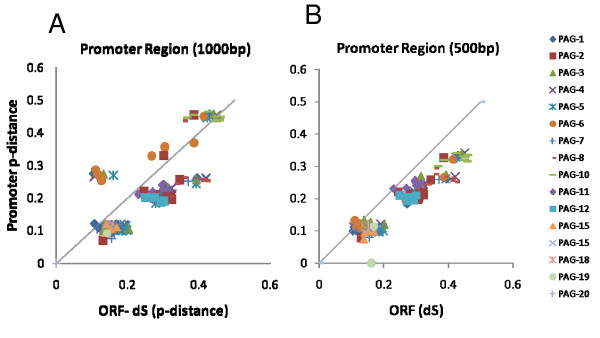
The ratio of p-distance (p-dist) of the promoter regions versus predicted nucleotide mutation rate [calculated as dS (proportion of synonymous substitutions per synonymous site in the exons)] in pairwise comparisons for each PAG gene represented in the genome build. A. Comparisons with the proximal 1000 bp of the promoter region. B. Comparisons with the proximal 500 bp of the promoter region. The p-distance of the promoters was shown on the Y-axis and the dS of their protein coding regions were displayed on the X-axis. The unique marks of a particular color and shape in the figure represent the pairwise comparisons of boPAG against each of the other PAGs included in the analysis. The listing of PAG genes and their indicators are shown in the legend.